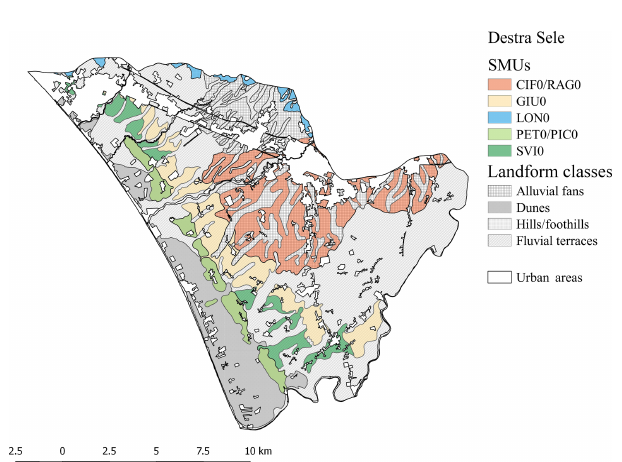
Figure 1. The four landform classes of the Destra Sele area and the soil map units (SMUs) of selected six soil typological units (STUs, which are similar to the USDA soil series) (CIF0/RAG0, Cifariello; GIU0, Giuliarossa; LAZ0, Lazzaretto; LON0, Longob- arda; PET0/PIC0, Picciola; SVI0, San